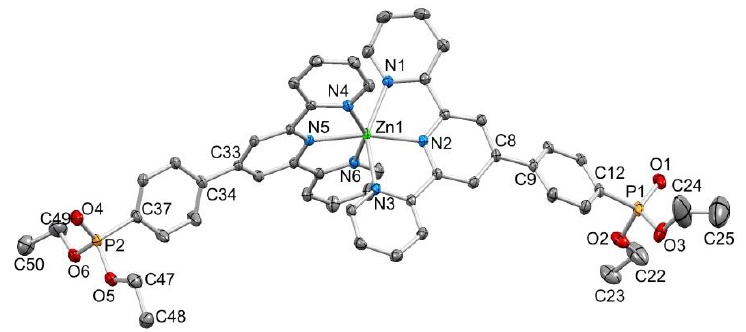
Figure 4. ORTEP-style diagram of the [Zn( 2 ) 2 ] 2+ cation. Ellipsoids plotted at 50% probability level; H atoms omitted. Selected bond parameters: Zn1–N1 = 2.2139(16), Zn1–N2 = 2.0760(14), Zn1–N3 = 2.2310(15), Zn1–N4 = 2.1701(15), Zn1–N5 = 2.0793(14), Zn1–N6 = 2.2157(15), P1–O1 =